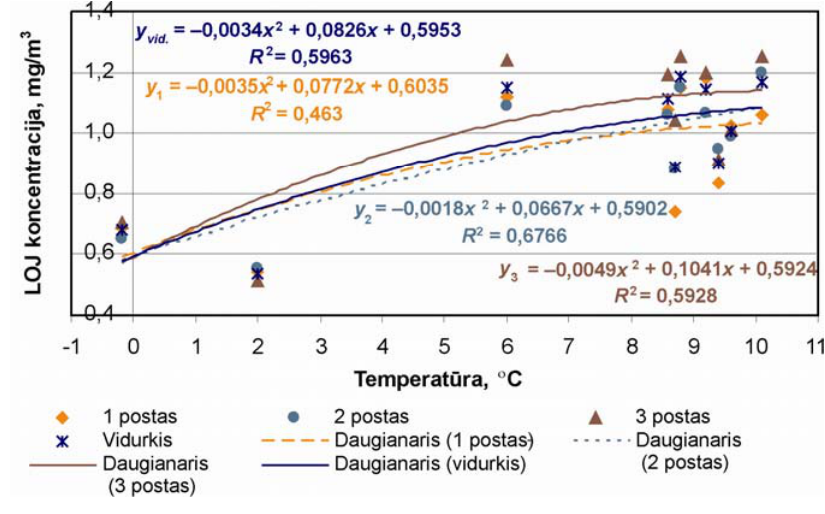
Fig 5. Dependence of VOC concentration in ambient air on temperature (10-day results)